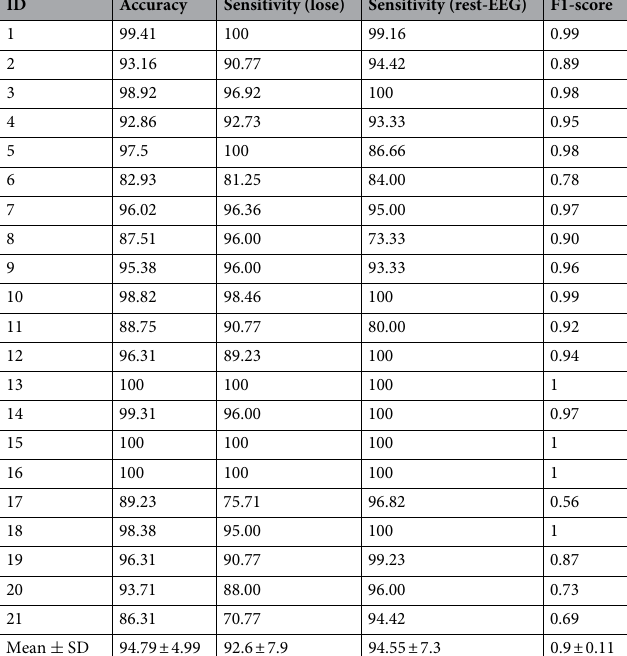
Table 2. The accuracy and sensitivity of LOSE and rest-EEG classes, and F1 score results for each participant for task 3.